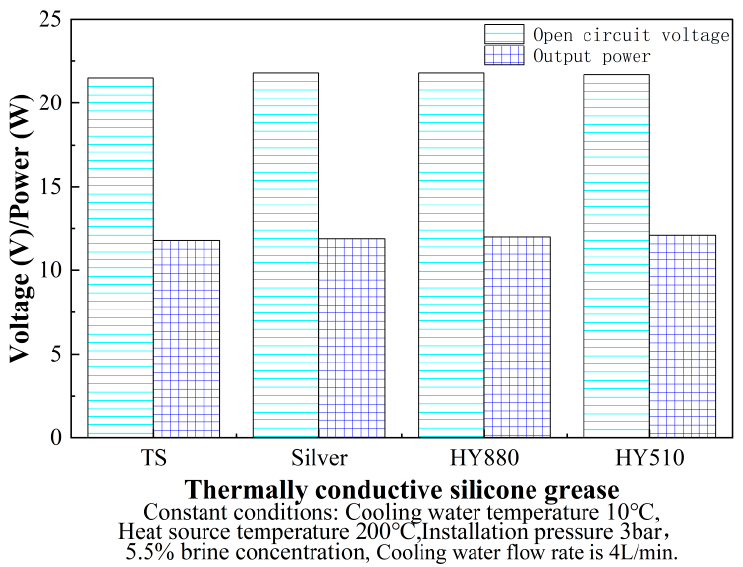
Figure 7. Effect of different thermally conductive silicone greases on open-circuit voltage and output power.